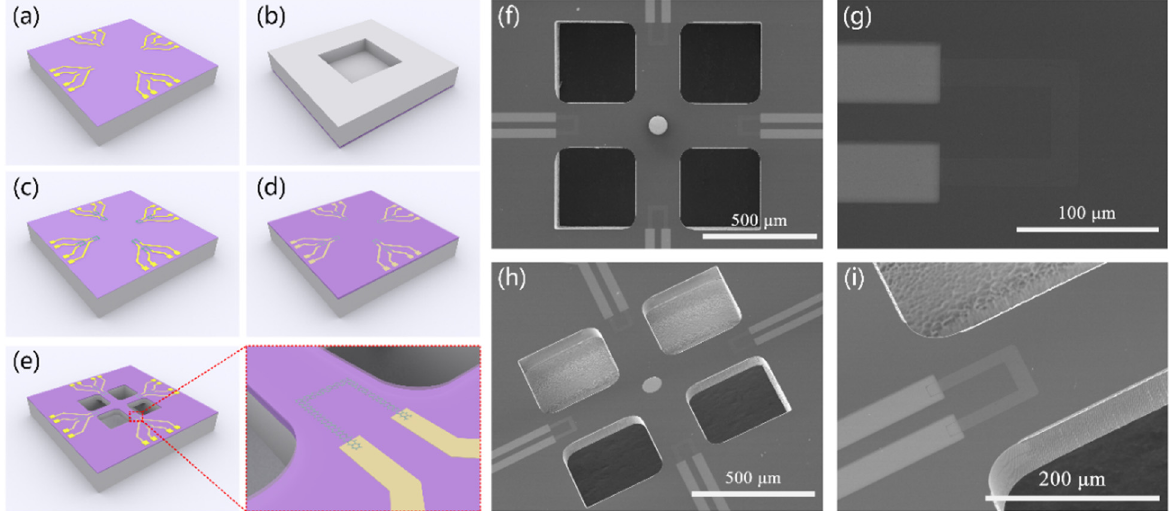
Figure 1. Fabrication process and SEM images of crossbeam structure with graphene sensing element. ( a ) Sputtering Cr/Au electrode. ( b ) Etching deep square cavity on the back of wafer. ( c ) Transferring and patterning monolayer graphene. ( d ) Depositing protective layer of Si 3 N 4 and etching Si 3 N 4 to leak out the Pad and sputtering Cr/Au on it. ( e ) Release crossbeam structure. ( f ) Top view of whole chip. ( g ) Top view of single graphene element. ( h ) Tilt observation of whole chip. ( i ) Tilt observation of single graphene element.